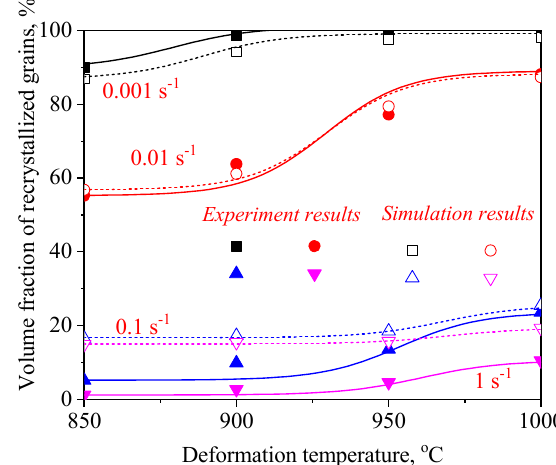
X after DRX X after DRX